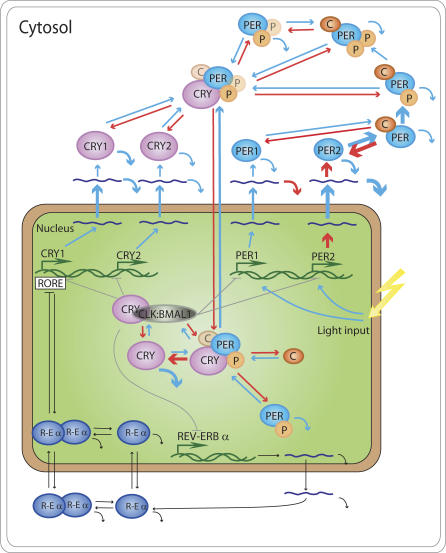
Graphical Representation of Results of Detailed Sensitivity AnalysisRed, positive sensitivity; blue, negative sensitivity; black, zero sensitivity; gray, not modeled explicitly; thick arrow, large magnitude; thin arrow, small magnitude; curved arrow, degradation; R-Eα, REV-ERBα; RORE, target sequence for retinoic acid–related orphan receptor R-Eα on Cry1 promoter; P, phosphorylated; C, CK1. The CRY-CLK:BMAL1 complex does not inhibit transcription, but rather diverts the activator CLK:BMAL1 from the transcription initiation site. The effect of light input is modeled as an increase in per1 and per2 transcription, identical for both. In the interest of visualization, only Per2 pertinent sensitivities are represented where one arrow represents multiple processes. In those cases, the Per2-related sensitivities were always significantly larger in magnitude than any other sensitivities.